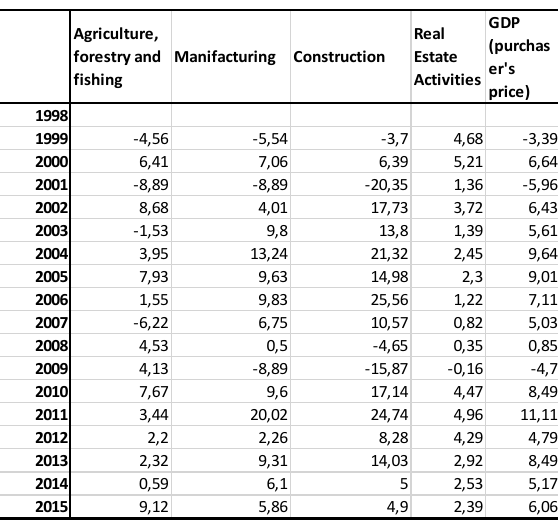
Figure 1. Gross Domestic Product Change (%) for 1999- 2015 Period It can be seen from the above figure that, 2000- 2001 and 2007-2008 economic crises made a negative effect on the economic growth of Turkey and there were sharp declines at these periods. Table 3: The Growth Rate at Selected Sectors in Turkish Economy Growth rate in selected sectors (Gross Domestic Product in chain linked volume, index and percentage change (2009=100), by kind of